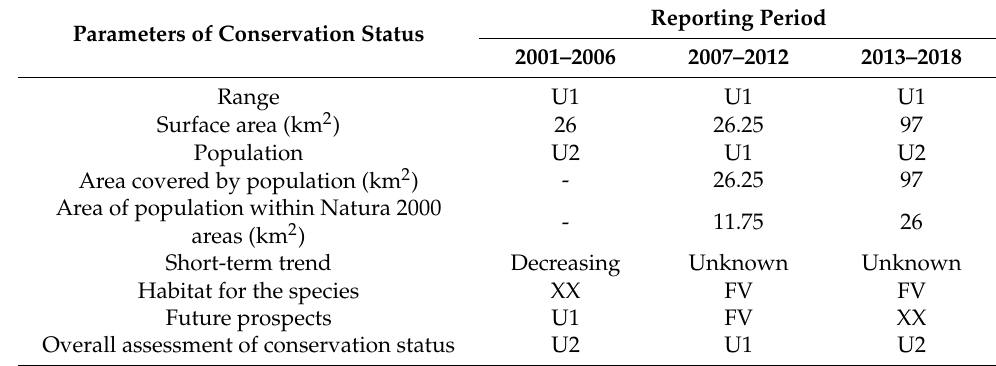
Table 1. Summary of the biogeographical assessment for N. n. cypriaca, at the member state level, for the last three reporting periods (2001–2018). FV, favourable; XX, unknown; U1, unfavourable– inadequate; U2, unfavourable–bad. Unknown: trend is reported as unknown due to absence of sufficient